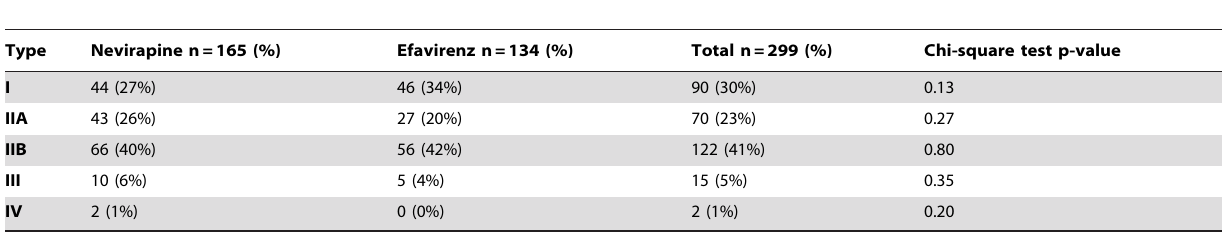
Table 2. Severity of NNRTI-related skin rashes among Ghanaian HIV